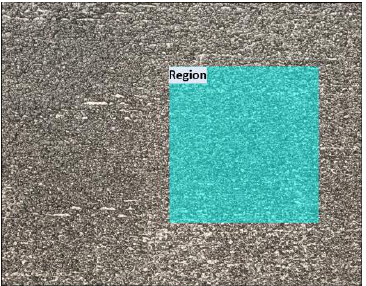
Figure 4. Finite element model of the wing. Table 3. Natural frequencies of the wing obtained from the test and simulation.